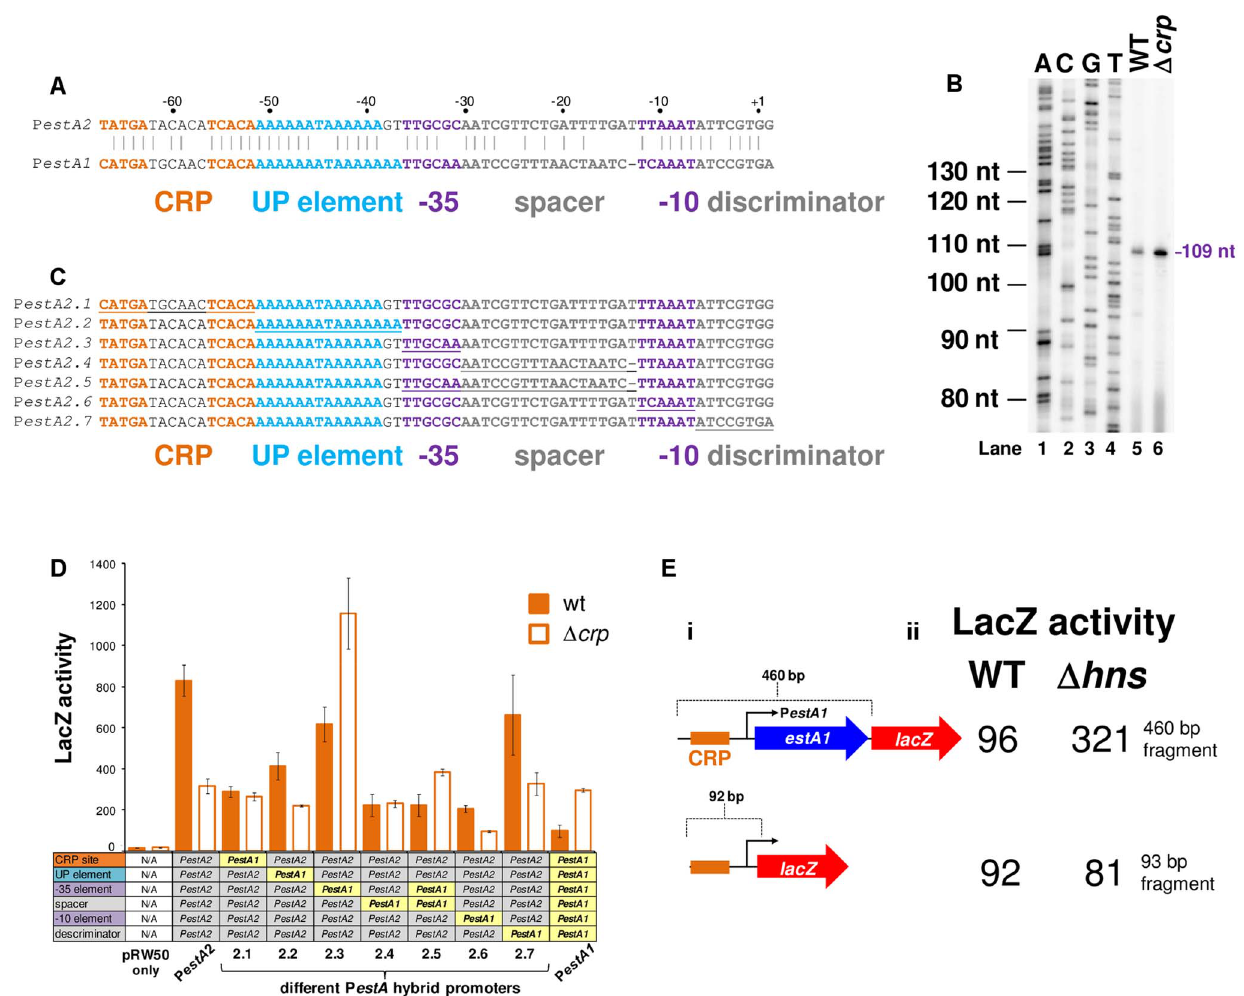
Fig. 5. Comparison of P estA1 and P estA2 reveals differential activity and regulation by CRP. A) Comparison of P estA1 and P estA2 . The panel shows the DNA sequences of P estA1 and P estA2 . Bases that are identical are highlighted by a solid vertical line. The CRP sites are shown in orange, the UP element in blue and the core promoter elements in purple. The sequences are numbered with respect to the transcription start site ( + 1). B) Location of the P estA1 transcription start site. The gel shows products from an mRNA primer extension analysis (Lanes 5 and 6). The gel was calibrated using arbitrary size standards (A, C, G and T in Lanes 1–4). C) Sequences of hybrid estA promoters. The sequences labelled estA2.1 through estA2.7 are derivatives of the 93 bp P estA2 DNA fragment where different sequence elements have been replaced with the equivalent sequence from P estA1 . D) The bar chart shows b -galactosidase activity measurements for lysates obtained from cultures of M182, or the D crp derivative, containing the indicated hybrid promoter fragment was fused to lacZ . E) The panel shows different P estA1::lacZ fusions. The lacZ gene is shown as a red arrow and the estA1 gene is shown as a blue arrow. P estA1 is illustrated using a bent arrow and the CRP binding site is shown as an orange box. Assays were done in LB